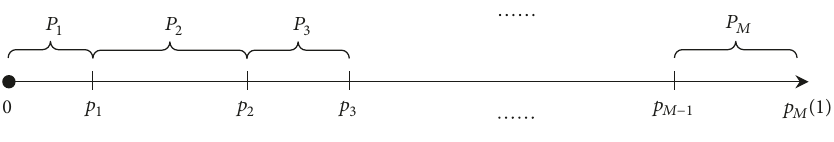
Figure 9: Roulette